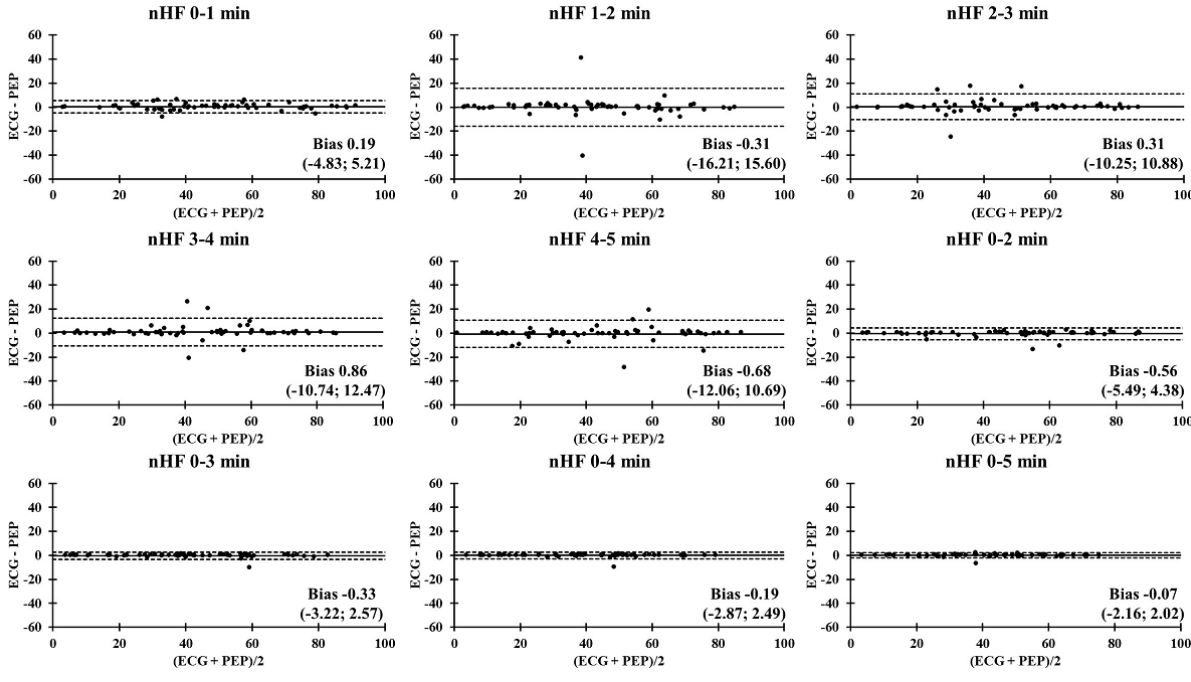
Figure 9. Bland-Altman analysis comparing the ECG and Pulse Express PRO measurements in ultra–short-term and short-term recordings of normalized high frequency power (nHF). The solid line represents the mean difference and the upper and lower dashed lines represent the upper and lower limits of agreement (± 1.96*SD). ECG: electrocardiogram; PEP: Pulse Express